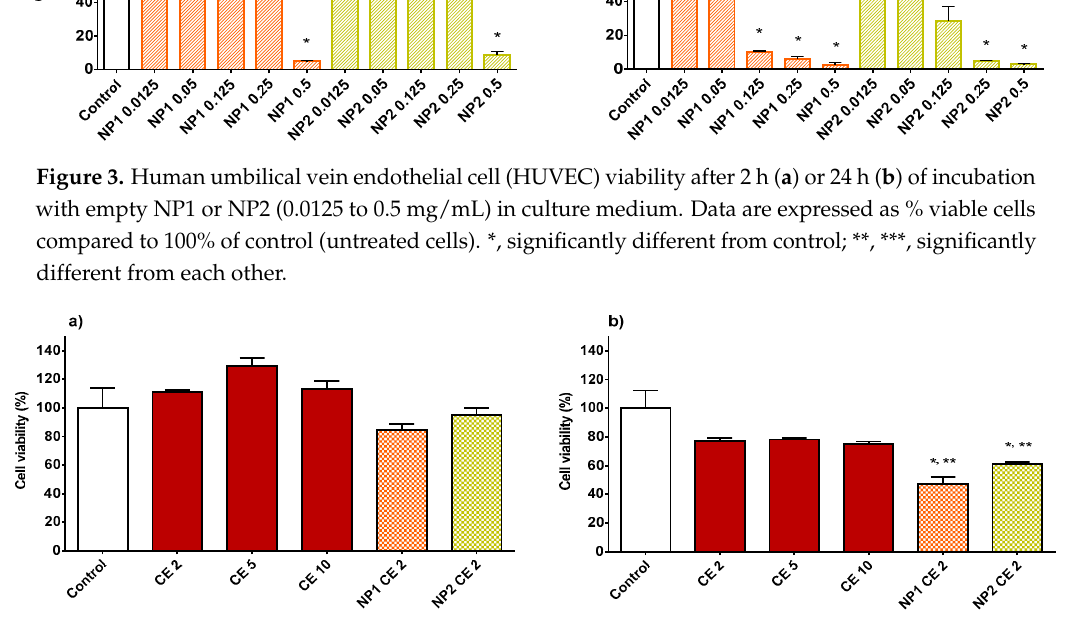
Figure 4. HUVEC viability after 2 h ( a ) or 24 h ( b ) of incubation with free CE (2, 5, 10 µ g/mL GAE) and CE-loaded NP1 or NP2 (CE concentration, 2 µ g/mL GAE) in culture medium. Data are expressed as % viable cells compared to 100% of control (untreated cells). *, significantly different from control; **, significantly different from each other.